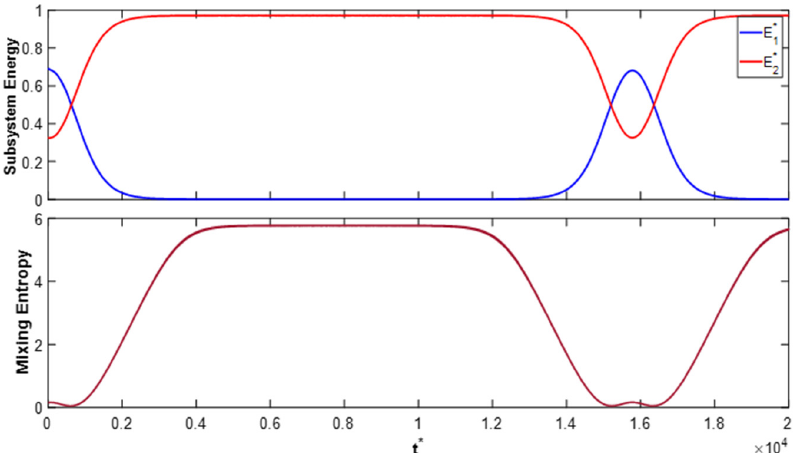
( a ), and q ∗ ( b ). i i ( c ), and q ∗ ( d ). i i